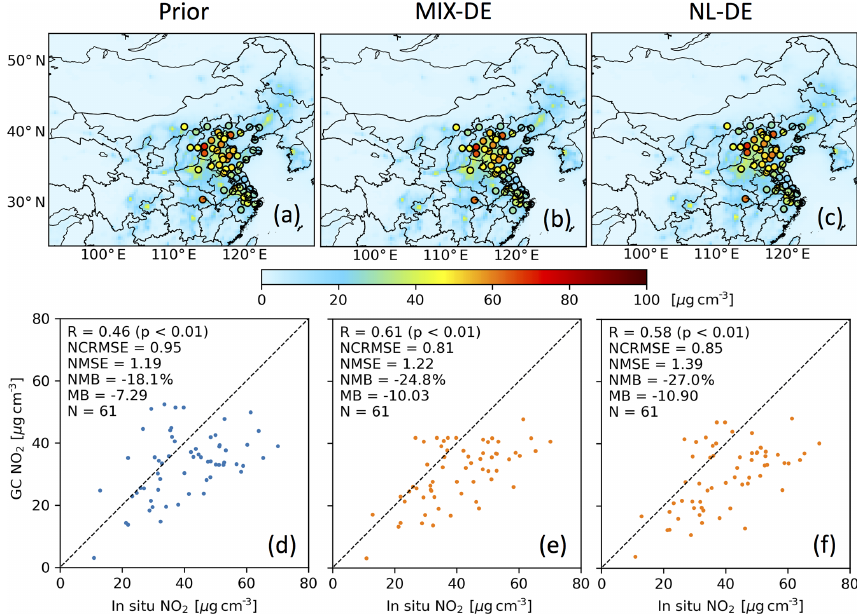
Figure 10. Evaluations of fine-resolution GEOS-Chem surface NO 2 simulations with in situ observations for October 2013. Panels (a) – (c) show surface NO 2 concentrations of F-PRI, MIX-DE-POS, and NL-DE-POS, respectively, with in situ observations overlapped. Panels (d) – (f) show scatter plots of F-PRI, MIX-DE-POS, and NL-DE-POS simulations versus in situ observations, respectively. The linear correlation coefficient ( R ), normalized centered root mean squared error (NCRMSE), normalized mean squared error (NMSE), normalized mean bias (NMB), mean bias (MB), and number of observations ( N ) are shown over scatter